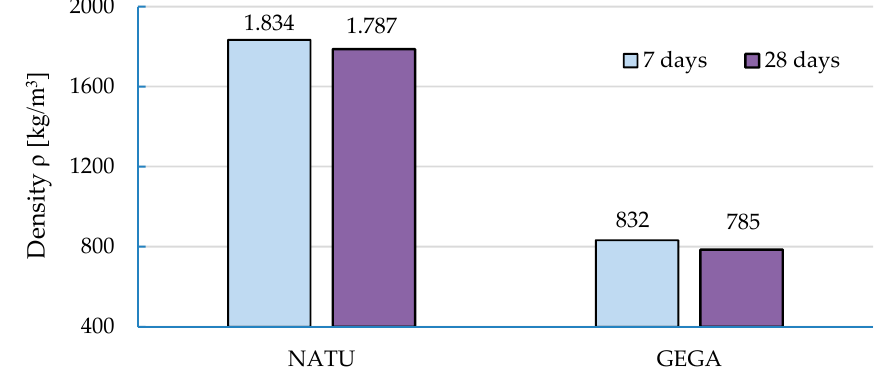
Figure 8. Change in apparent density.